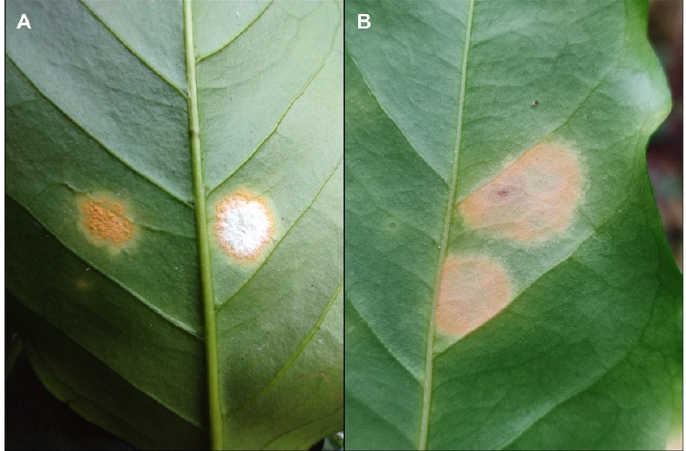
Figure 8. Active sporulation ( A , left ) and attack of CLR by a mycoparasite ( A , right ); dried appear- ance of CLR lesions sprayed with a systemic fungicide ( B ). Photos by Luis F. Aristizábal.